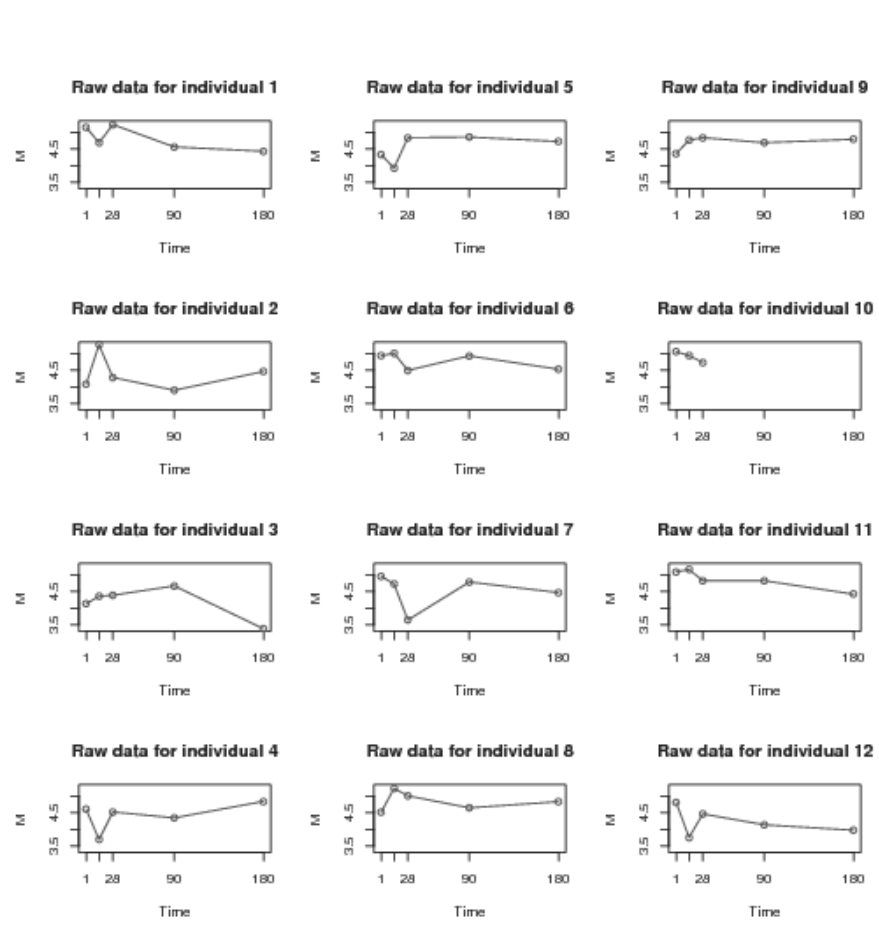
Figure 1 – Raw data for TMEFF1, females. Several key characteristics of the data can be observed: (1) irregularly spaced time points (2) missing data - individual 10 is only observed for the first three time points (3) significant individual heterogeneity (4) noisy